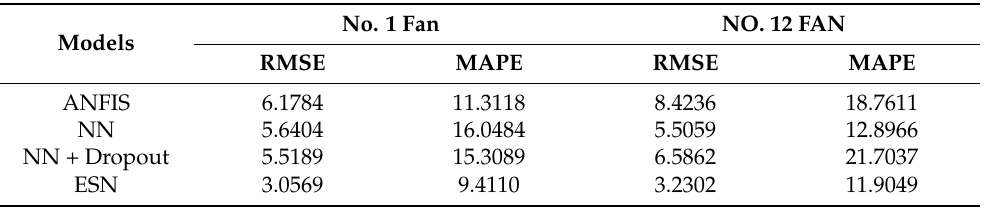
Table 2. Experimental results of pitch motor temperature prediction.